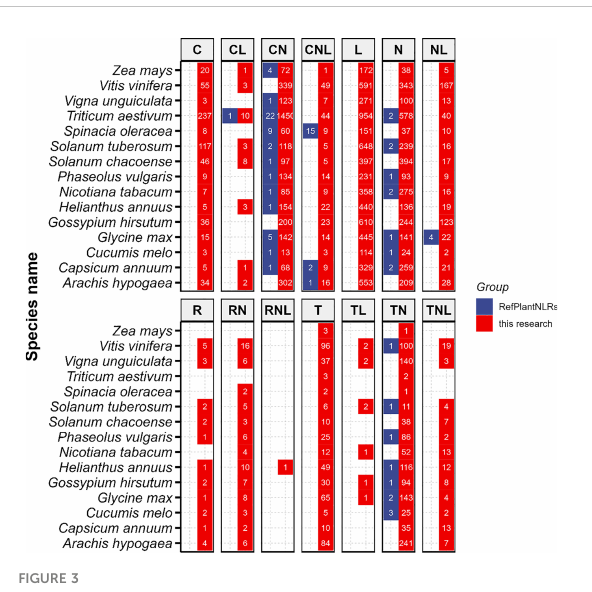
FIGURE 3 Comparison of NLR genes identi fi ed in this study with those in RefPlantNLR. Genes in RefPlantNLR are represented in blue, and genes in our study are represented in red. Numbers in each cell indicate the number of NLRs identi fi ed in each plant genome. Blank cells indicate that no NLRs were discovered in the plant genome.